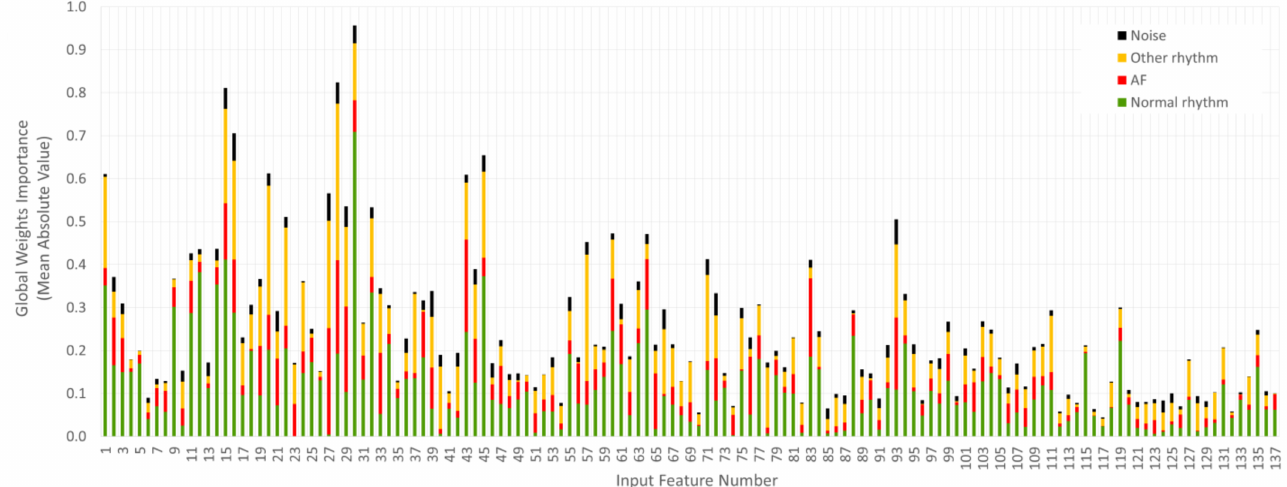
Figure 7. Global Weights Importance presented for 137 input features and four rhythm classes. The latter are used to construct stacked barplots, which present the mean absolute values computed by 20 × 5-fold independent runs of DenseNet-3@128- 32-4 model. The values are reported without